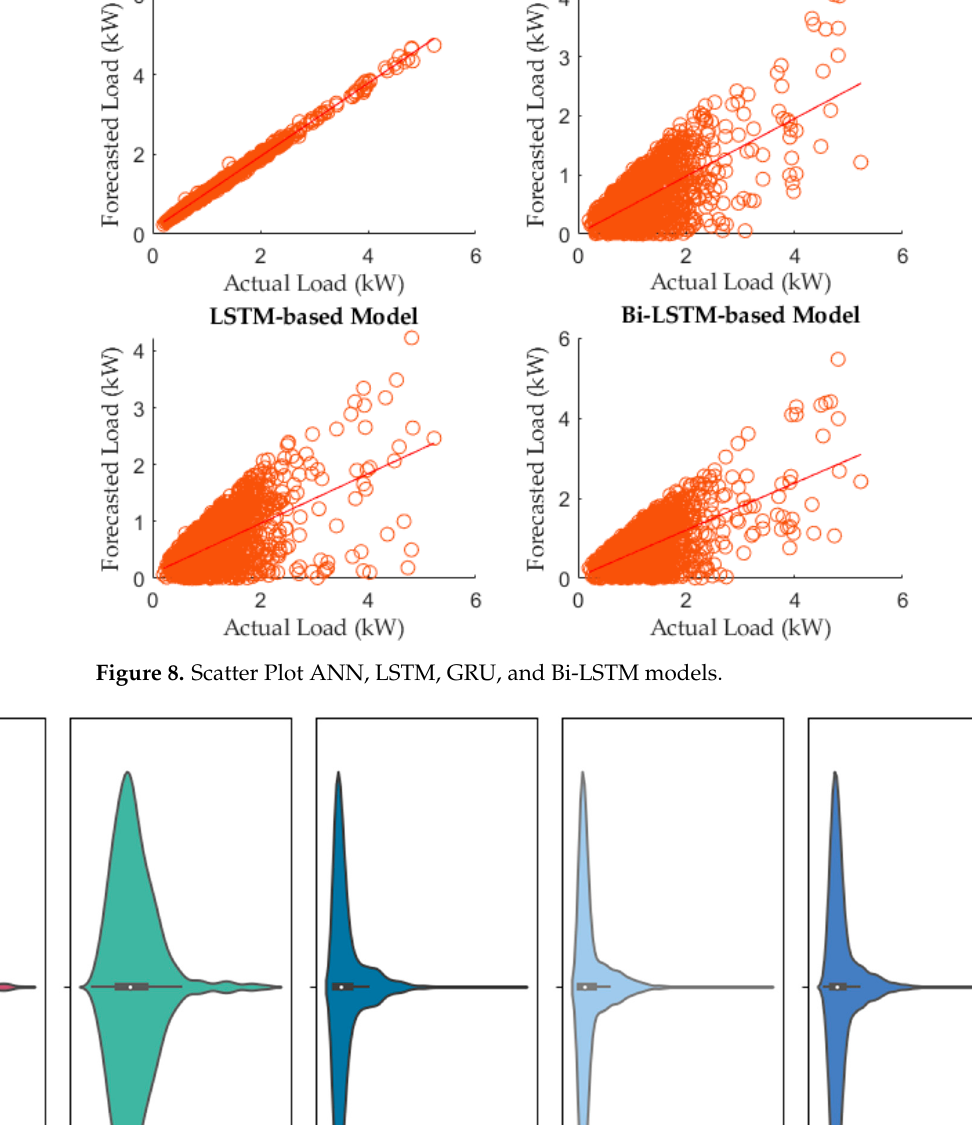
Energies 2022 , 15 , 6721 14 of 24